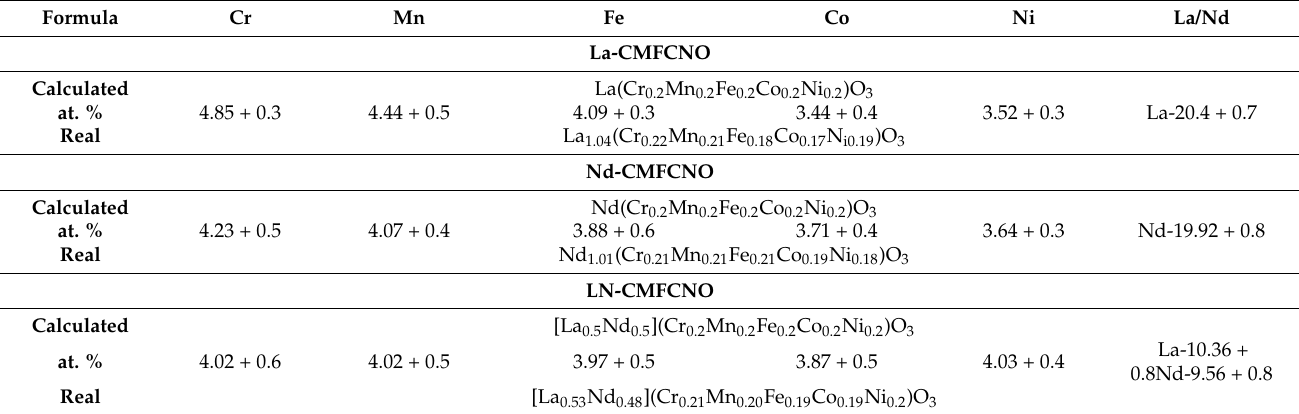
Table 1. Correlation of the nominal chemical composition (real formula) and initial stoichiometry (calculated formula) of the La-CMFCNO, Nd-CMFCNO and LN-CMFCNO ceramic